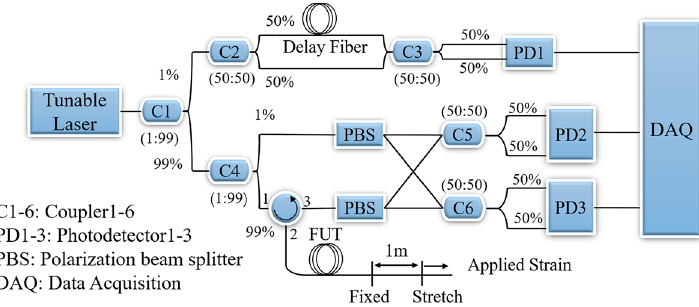
Figure 6. Schematic of the optical frequency domain reflectometry system.